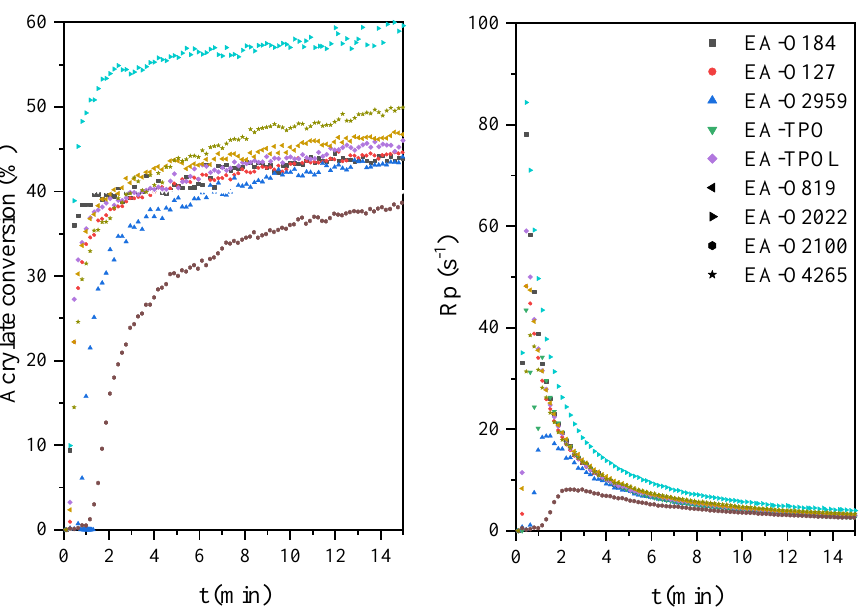
Figure 13. The acrylate conversion and photopolymerization rate curves of the epoxy acrylate formulations with radical photoinitiators.